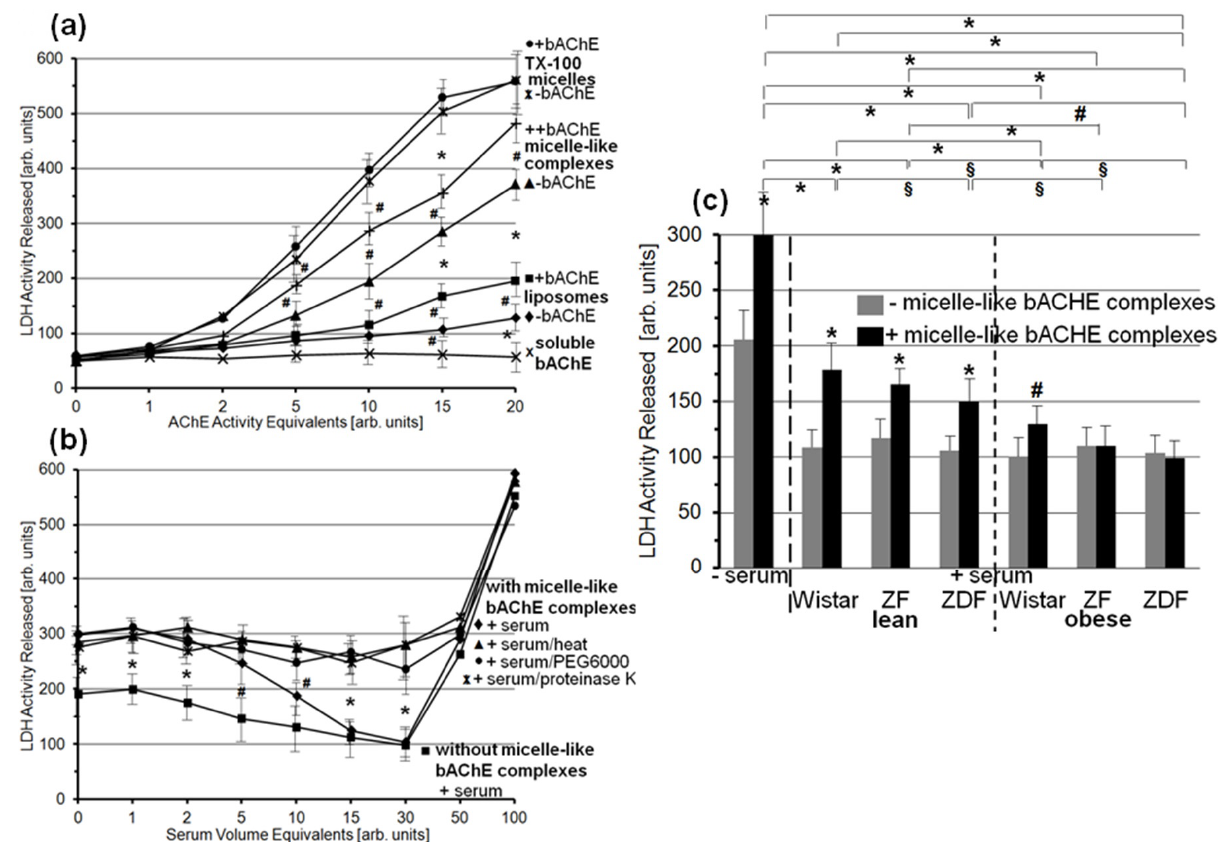
Figure 11. Effect of micelle-like bAChE complexes and serum on LDH release from rat adipocytes. ( a ) Isolated rat adipocytes were incubated (180 min, 37 °C) with micelle-like complexes that had been reconstituted in the absence ( ▲ ) or presence of bAChE (+), or with TX-100 micelles that had been reconstituted in the absence ( Ж ) or presence of bAChE (•), or with liposomes that had been reconstituted in the absence ( (cid:7) ) or presence of bAChE